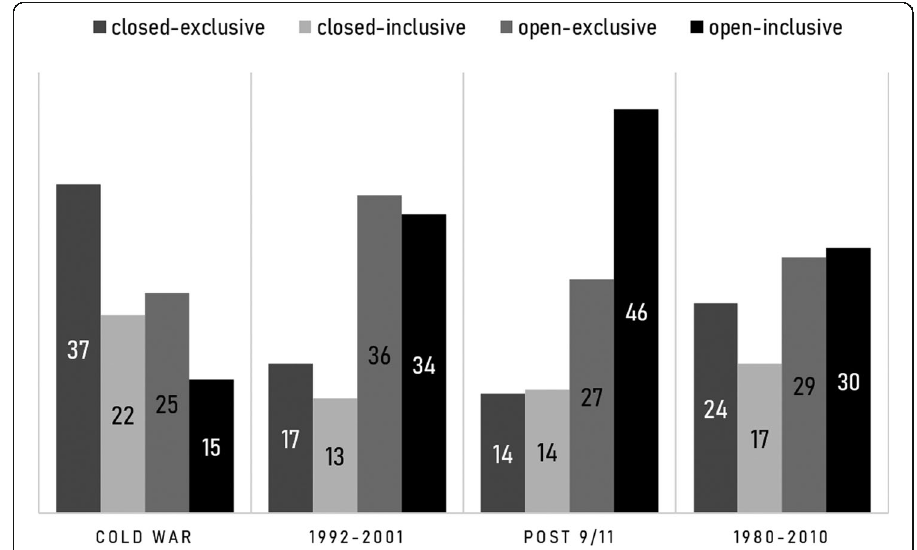
Fig. 2 National boundary regimes over time: ideal-typical empirical distribution. Bars indicate percentages; the categorisation is made according to whether an observation is above or below the arithmetic mean of IRO and CRI, respectively; Cold War period 1980 – 1991; Post 9/11 period 2002 – 2010; total period 1980 – 2010; N = 713 country-year